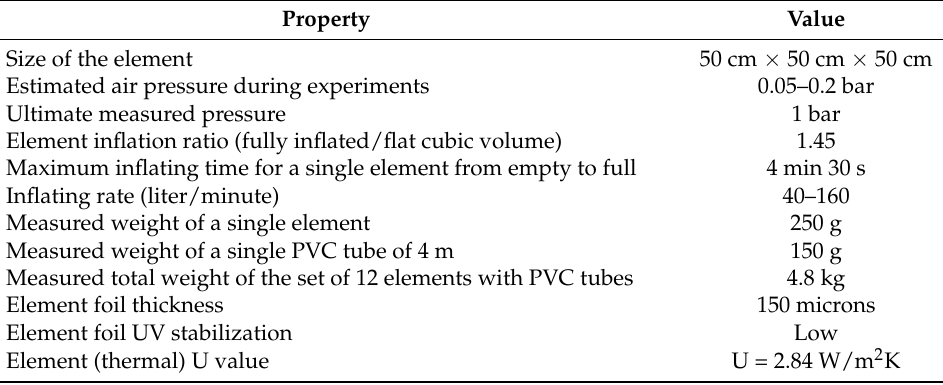
Table 2. Main properties of the tested